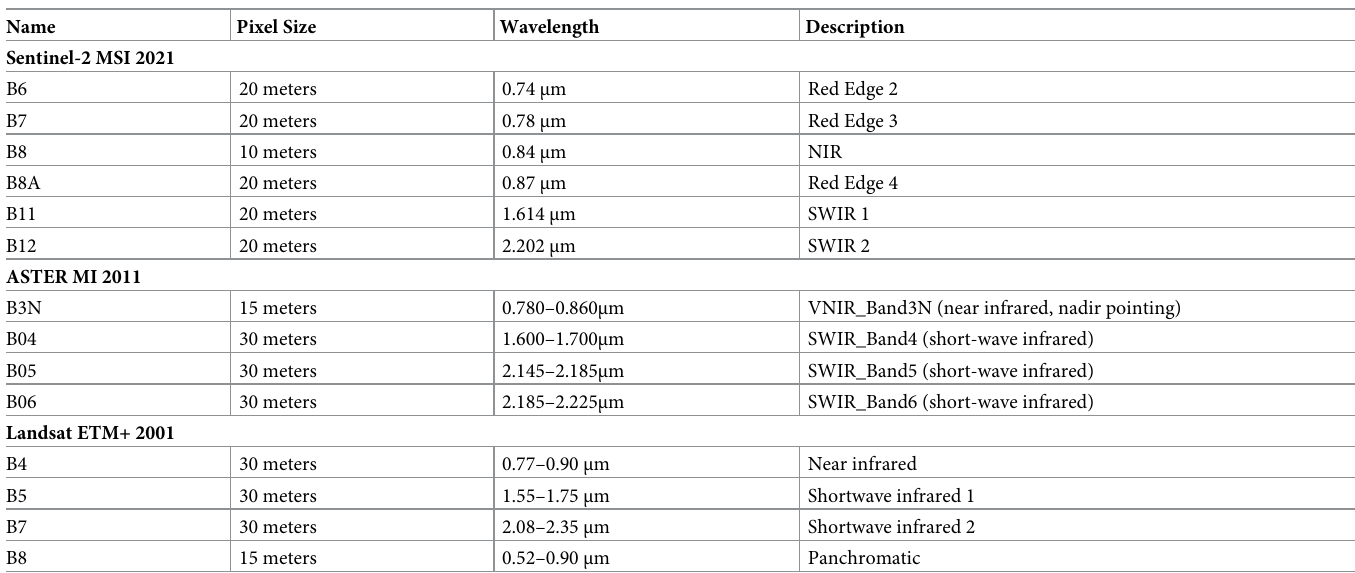
Table 1. Selected bands for classification.